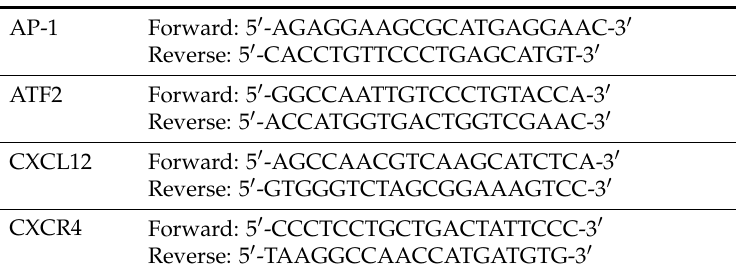
Table 1. Primers used in RNA